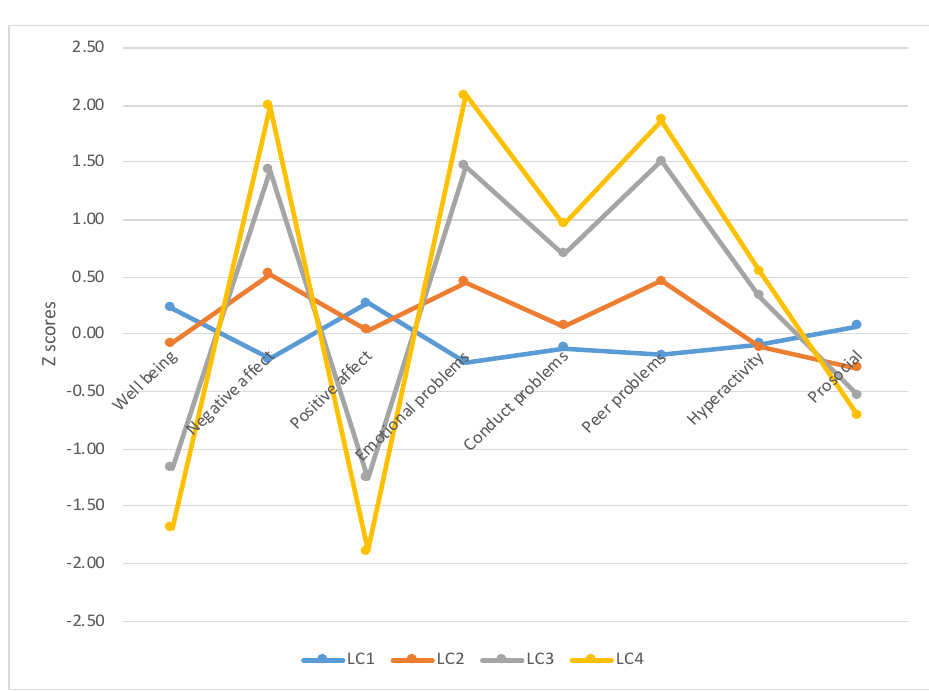
Figure 2. Social-emotional adjustment across latent classes.